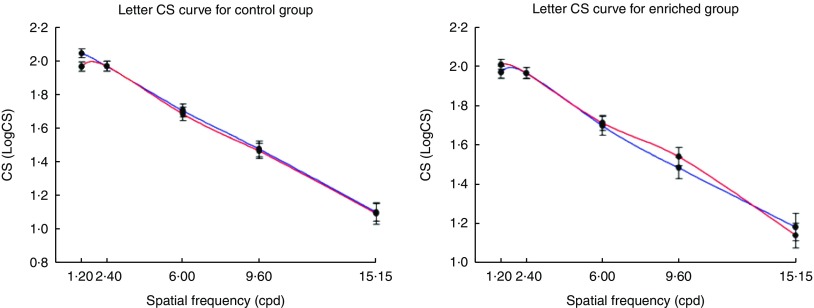
Change in letter contrast sensitivity (CS) values between baseline and final visit
(8 weeks) and at five different spatial frequencies: 1·20, 2·40, 6·00, 9·60 and
15·15 cycles per degree (cpd) using the Test Chart 2000 PROTM (Thomson
Software Solutions) in the Egg Xanthophyll Intervention Trial; control egg group
subjects; one standard egg per day. Enriched egg group subjects; one
lutein:meso-zeaxanthin enriched egg per day. An improvement in CS
at final visit in the enriched egg group relative to the control group is seen at
15·15 cpd reflected in the higher LogCS value. Values are means, with their standard
errors. , Baseline visit; ,
8-week visit.